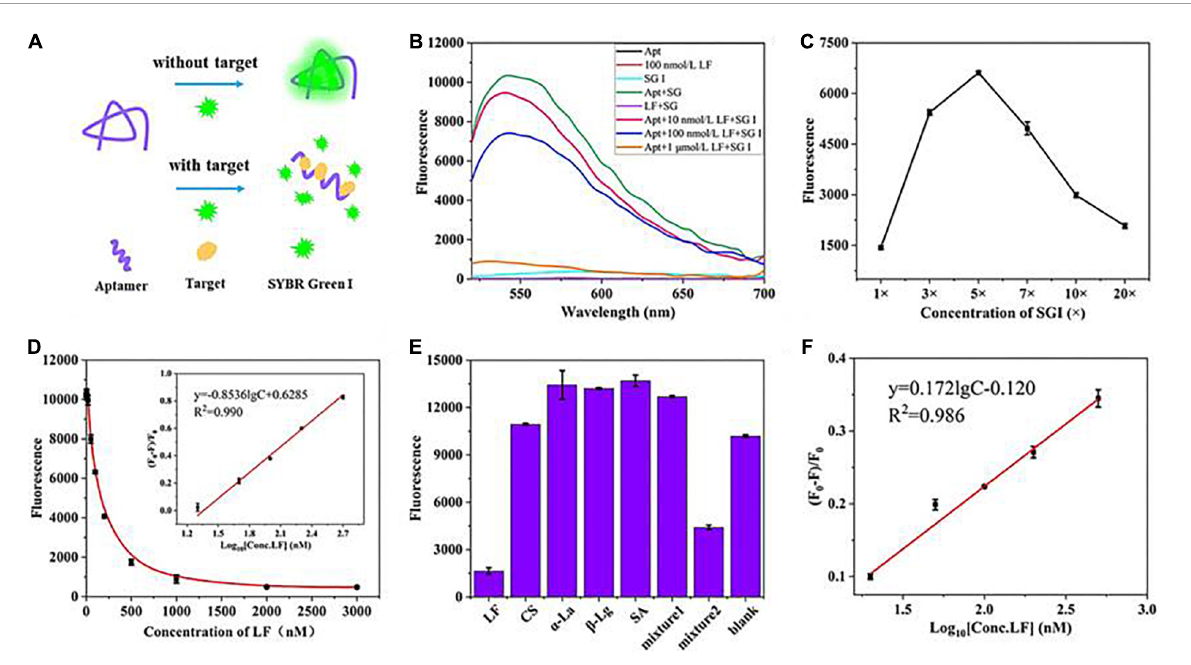
FIGURE4 (A) The principle of the fluorescence aptasensor based on SGI. (B) Feasibility verification. (C) Optimization of SGI concentration. (D) Relationship between fluorescence intensity and the concentrations of LF. (E) Evaluation of aptasensor specificity. (F) The linear relationship was obtained in the milk powder matrix between (F 0 –F)/F 0 and the concentrations of LF.